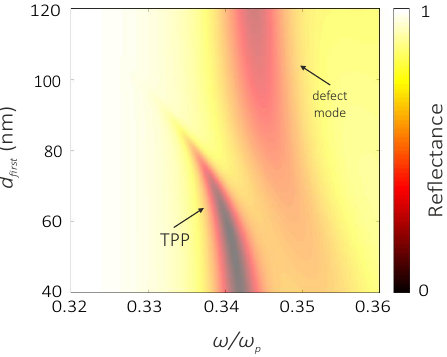
Figure 6. Reflectance spectra of the PhC/nanocomposite structure at the normal incidence of light